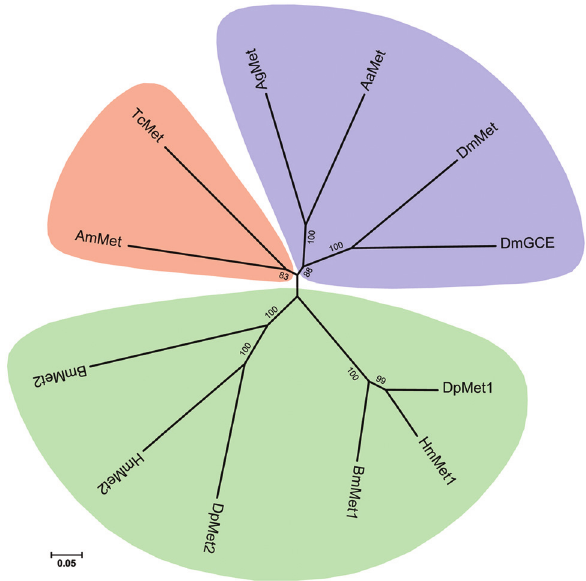
Figure 3 - Phylogenetic tree of the Met genes in B. mori and other insects. The amino acid sequences encoding by Met genes from seven insect spe- cies, including Bombyx mori (Bm), Drosophila melanogaster (Dm), Anopheles gambiae (Aga), Apis mellifera (Am), Tribolium castaneum (Tc), Danausplexippus (Dp),and Heliconiusmelpomene (Hm),wereused to build a phylogenetic tree. See Figure 2 for a detailed description of the approaches for constructing phylogenetic